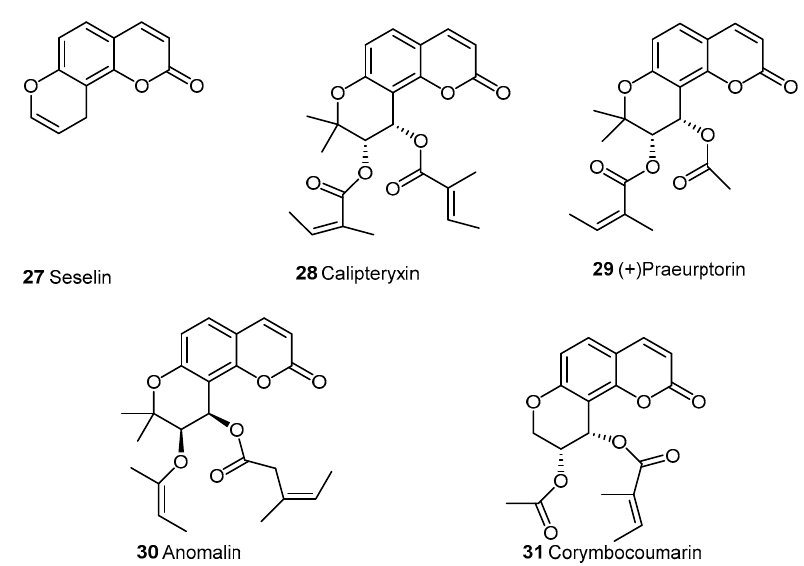
Figure 3. Naturally occurring pyranocoumarins.